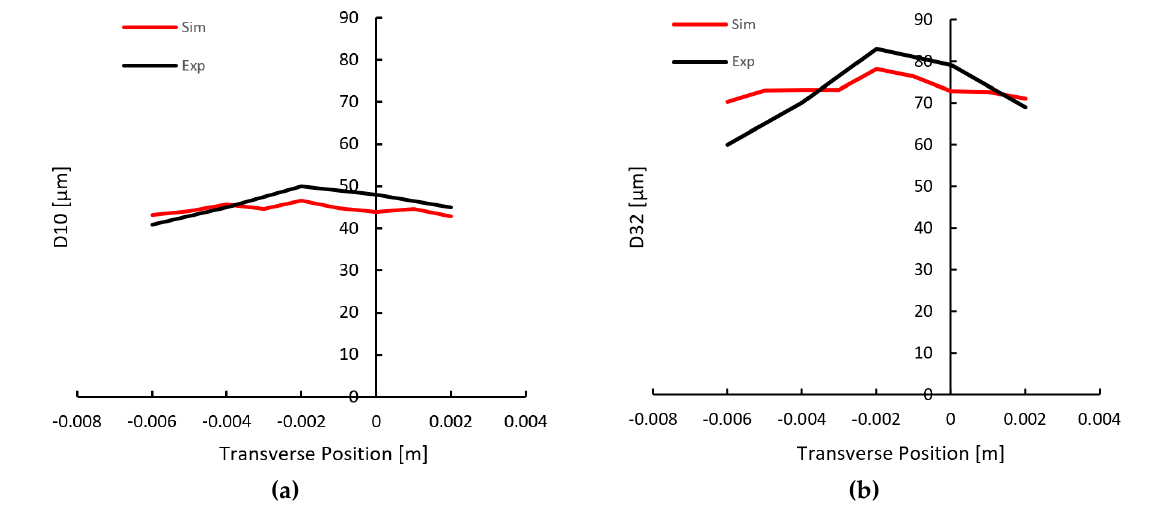
Figure 2. Spray angles definition ( a ), grid size effects on spray patterns ( b ) and on tip penetration ( c ) under conditions specified in Table 3.